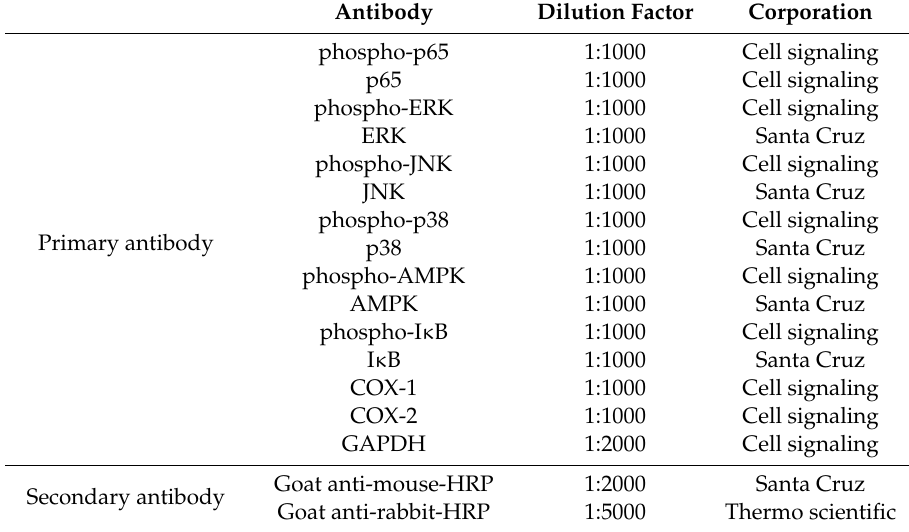
Table 1. Antibodies for western blot analysis.